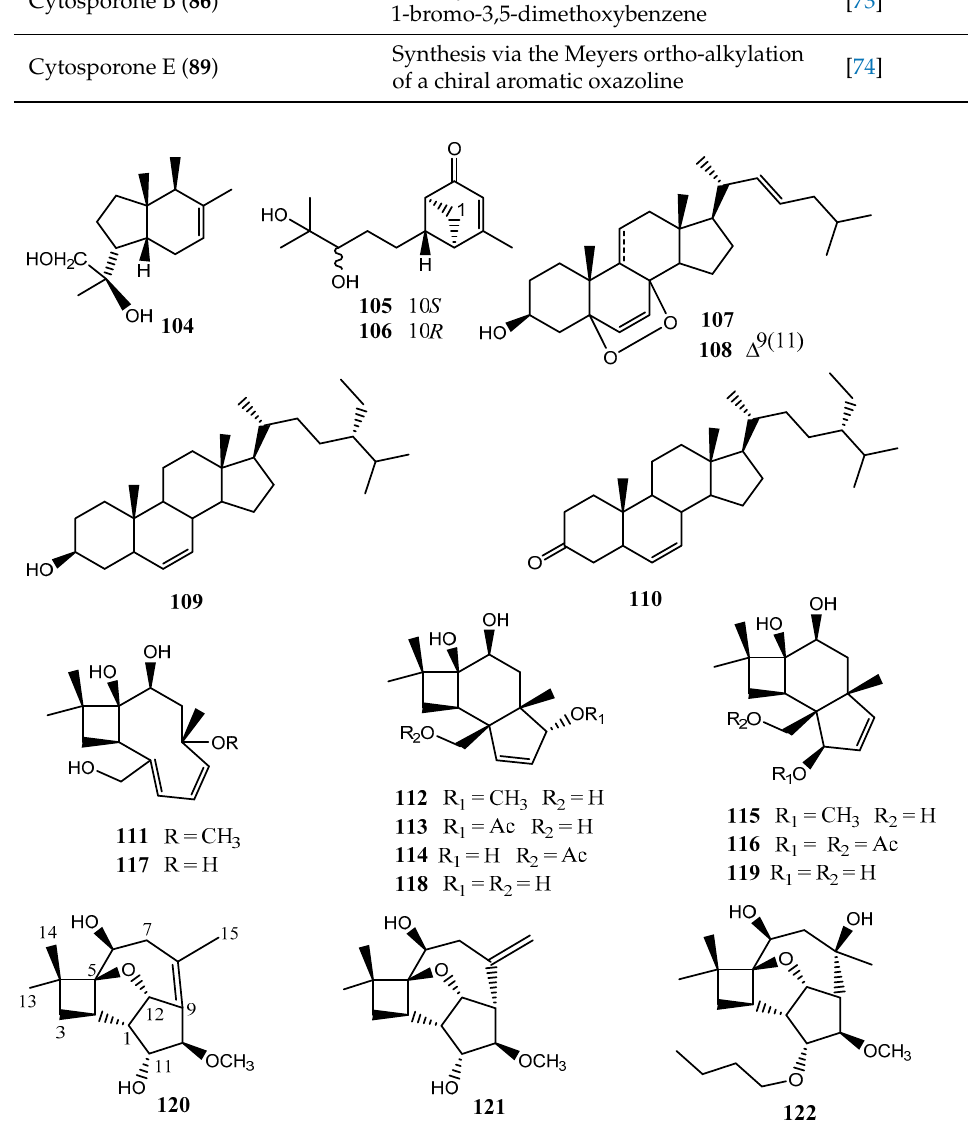
Figure 8. Terpenoids from the genus Cytospora.